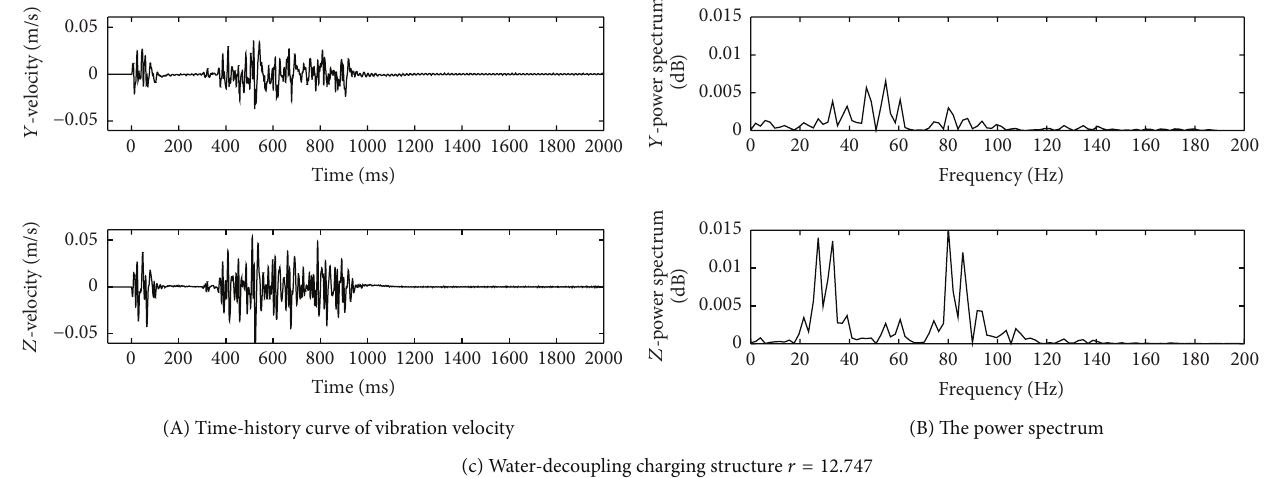
Figure 3: Schedule chart of different charging structures’ vibration velocity and power spectrum in three directions.